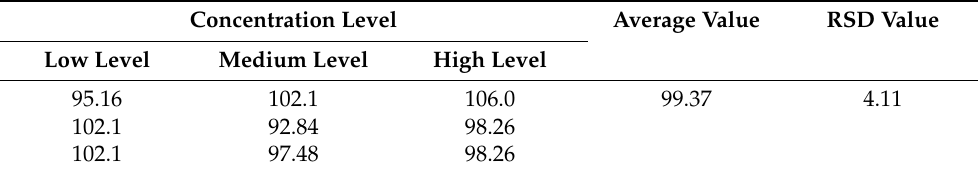
Table 4. Recoveries (%) of chlorogenic acid ( n = 3).